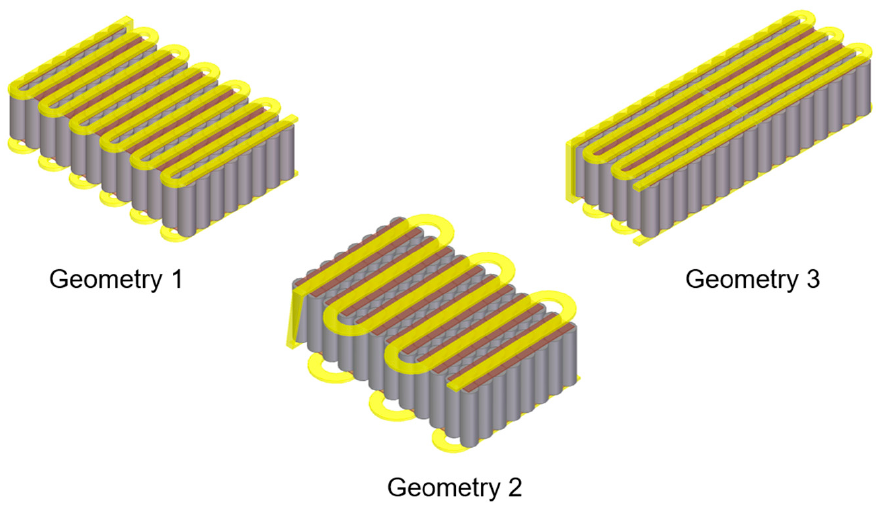
Figure 8. Hydraulic paths configuration to compare.